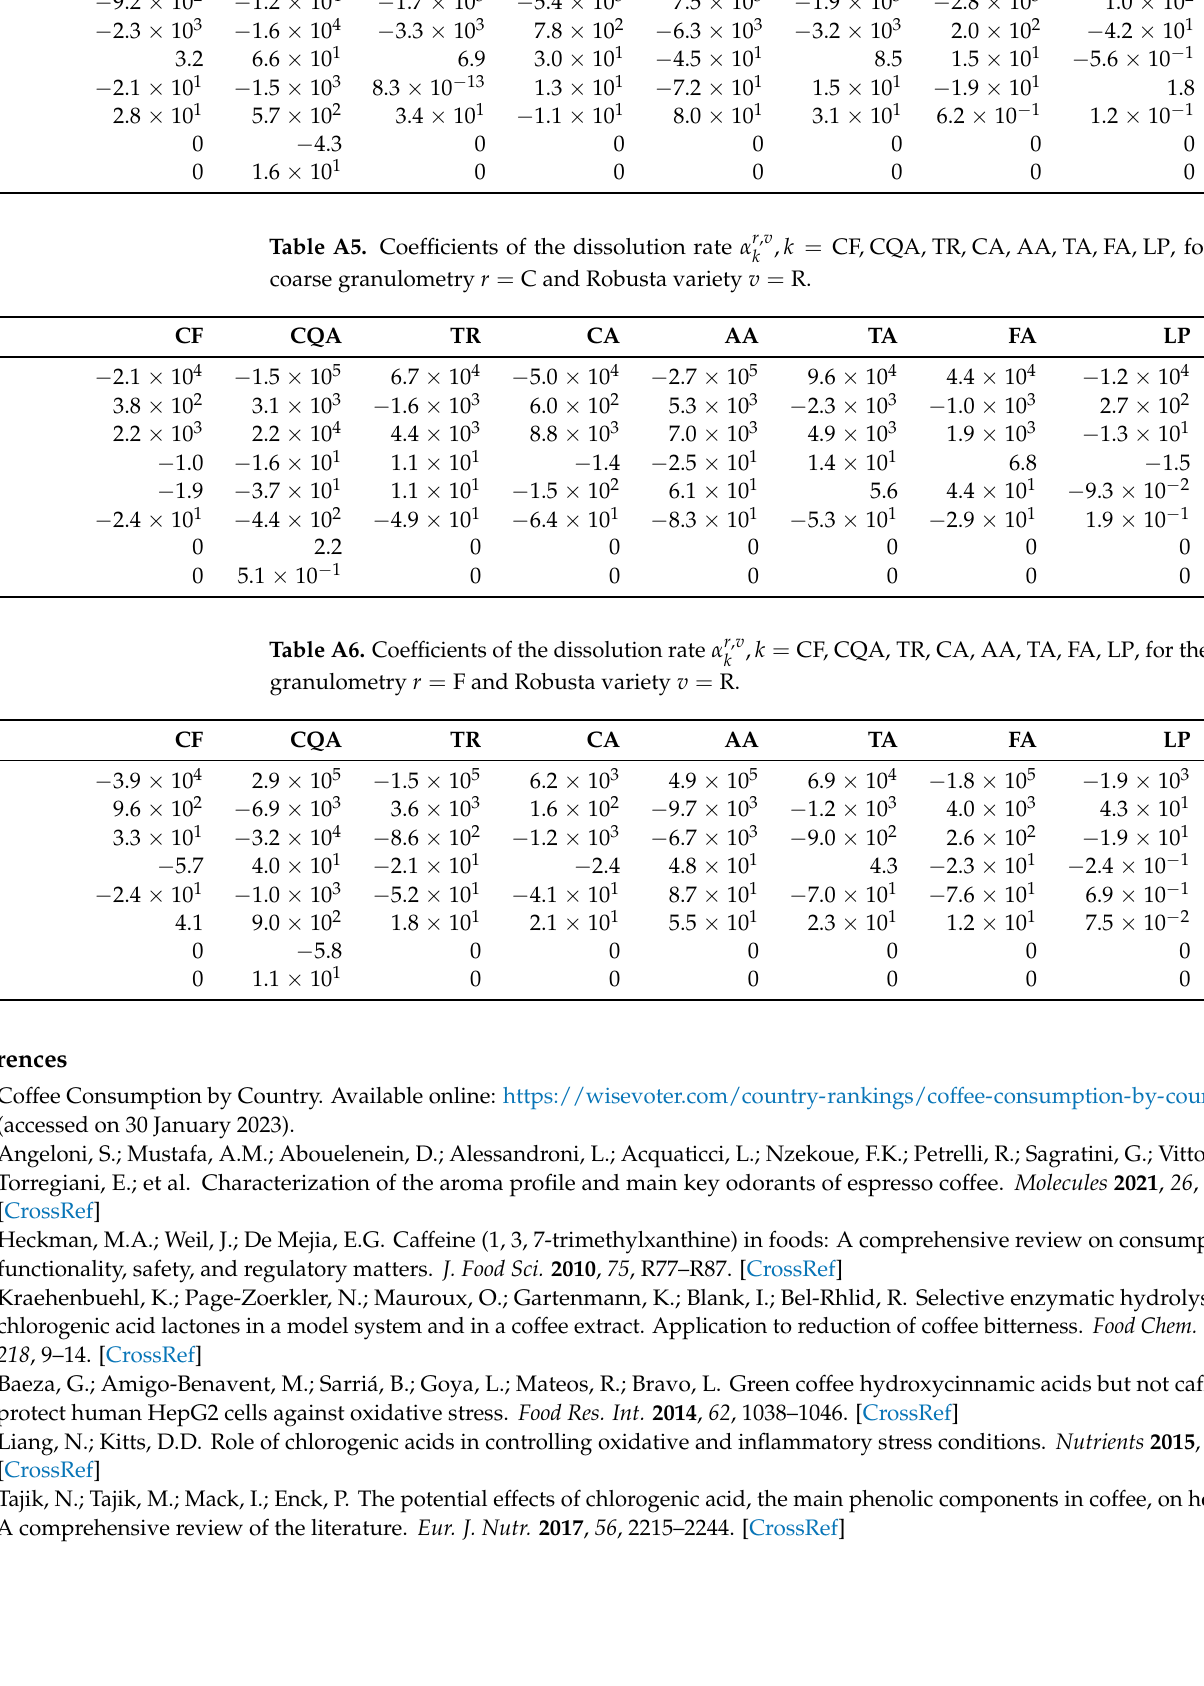
Table A4. Coefficients of the dissolution rate α r , v optimal granulometry r = O and Robusta variety v = R.